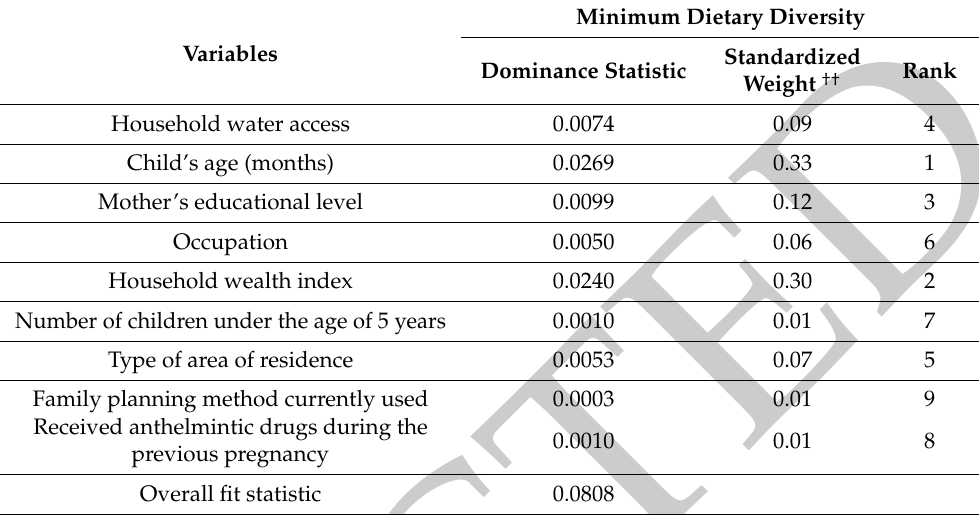
Table 4. Dominance analysis to determine the relative importance of the factors associated with minimum dietary diversity among children aged 6–23 months, in Malawi ( n = 4727). Minimum Dietary